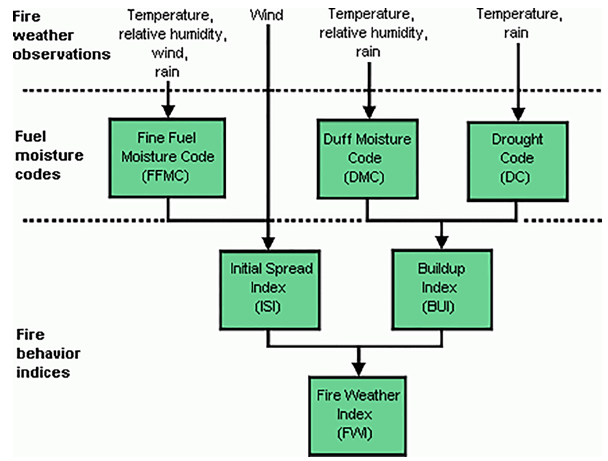
Figure 2. Identification of the Fire Weather Index (Natural Re- sources